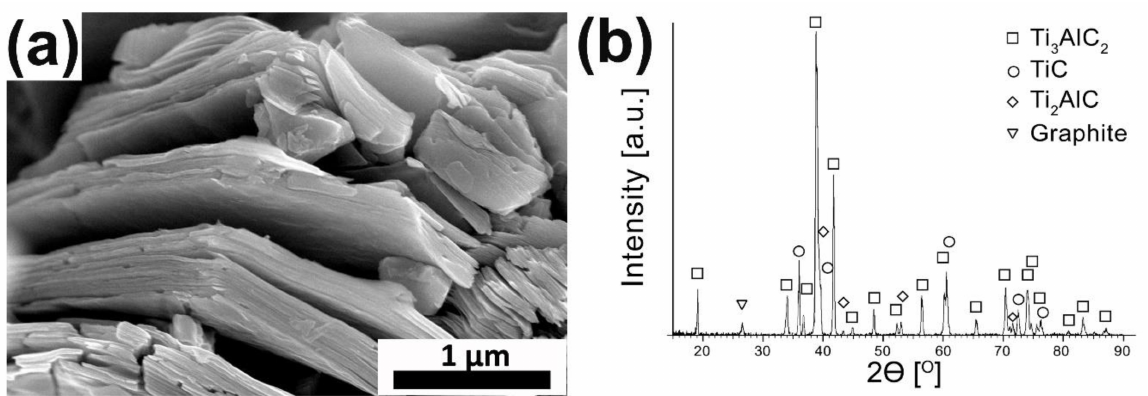
Figure 1. The ( a ) morphology and ( b ) XRD analysis of synthesized Ti 3 AlC 2 MAX phase